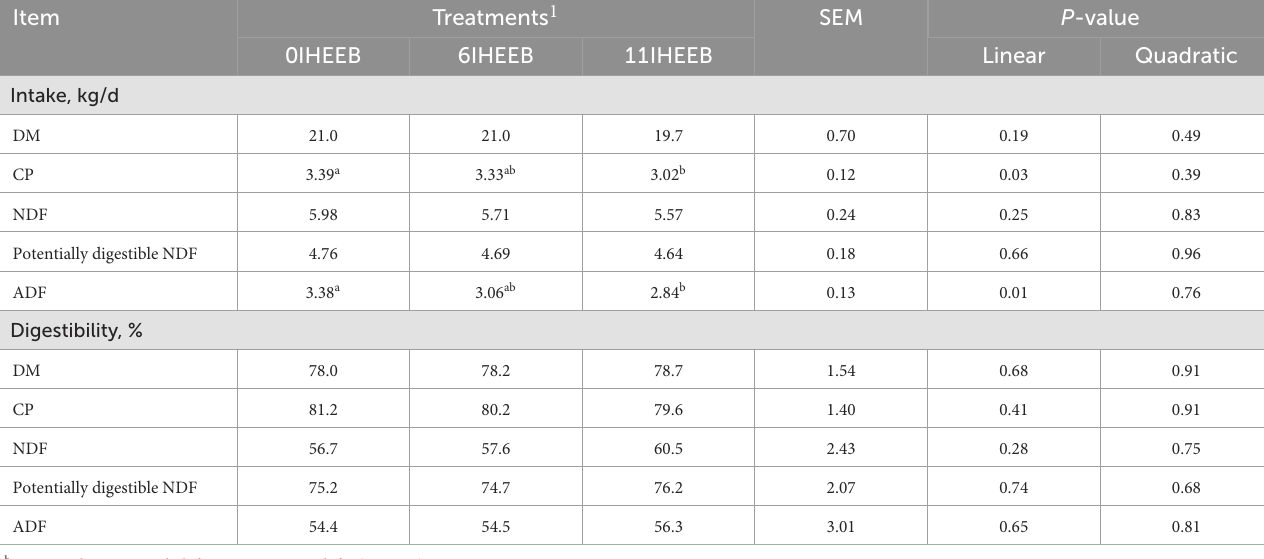
TABLE 3 Intake and total-tract apparent digestibility of nutrients in Holstein cows fed the 3 diets.